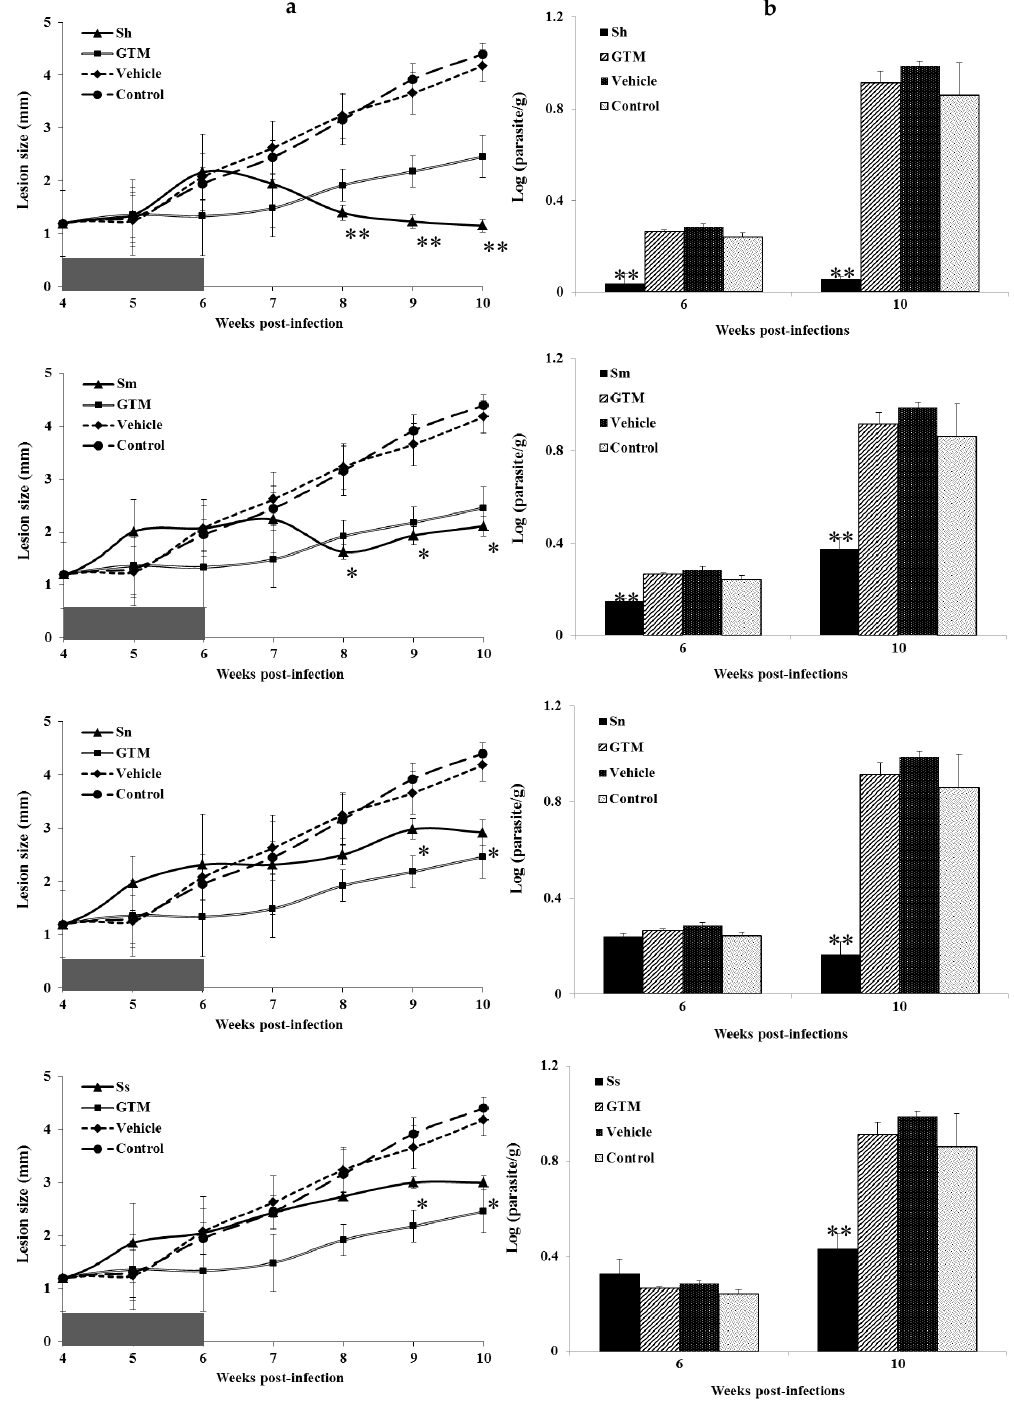
Figure 1. Effect of Solanum extracts on BALB/c mice infected subcutaneously with 5 × 10 6 promastigotes of L. amazonensis in the footpad. The results were expressed as mean ± standard deviation. Treatment was started after 4 weeks p.i. Five doses were administered by intralesional route each 4 days. Glucantime ® (GTM) and extracts from S. havanense (Sh), S. myriacanthum (Sm), S. nudum (Sn) and S. seaforthianum (Ss) were administered at a dose of 30 mg/kg. ( a ) Lesion size; and ( b ) parasite burden. Vehicle: 50 µ L of saline solution:dimethylsulfoxide (7:3, v : v ); control: infected and untreated mice. * Statistically significant difference ( p < 0.05) compared with the vehicle and the control group. ** Statistically significant difference ( p < 0.05) compared with GTM, the vehicle and the control